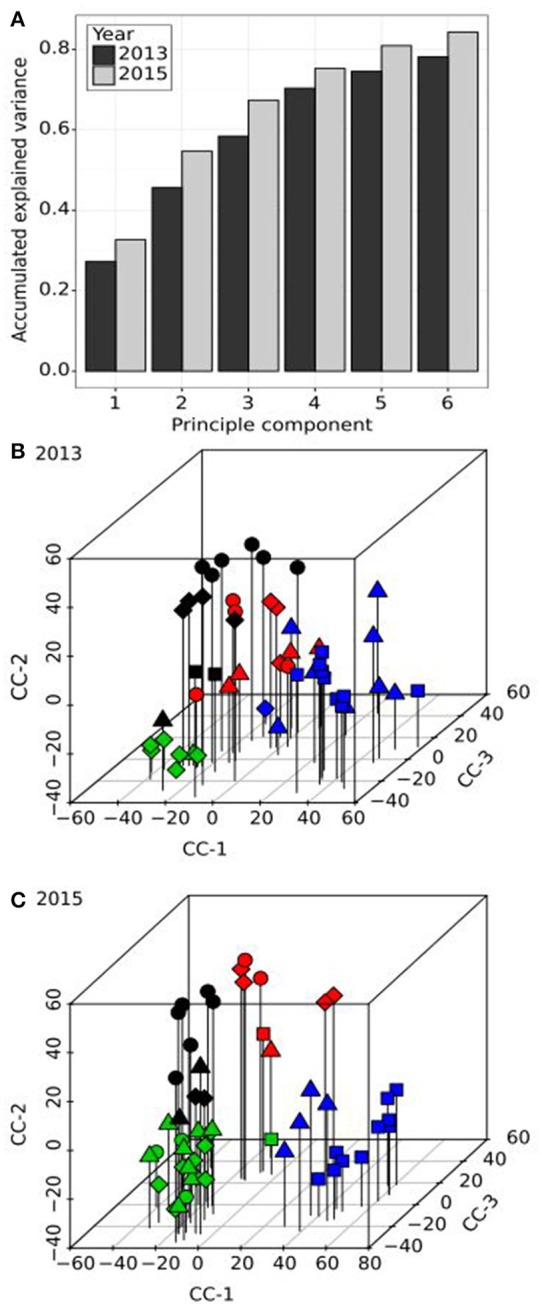
Principal component (A) and cluster analysis (B,C) of the compatibility scores from diallel crosses in the F13 population. (A) The accumulated explained variance (y-axis) of the first six principal components (x-axis) are shown as dark and light grey bars for the evaluations in 2013 and 2015, respectively. (B,C) three-dimensional scatterplots of the resulting compatibility components (CC-1 to CC-3) for both years. The shape of the symbols represents the half-sib family origin of each genotype of the F13 population (square, circle, triangle and diamond for half-sib families HSF-1 to HSF-4, respectively). The symbol colours are representative of the first four clusters based on hierarchical clustering analysis (black, red, green, and blue, respectively).